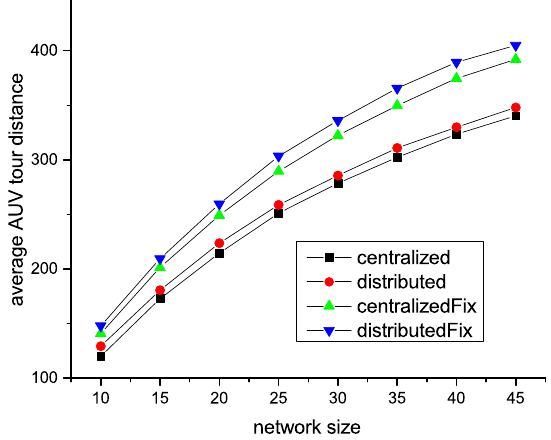
Figure 6. Tour vs. network size with different sink sensor selection